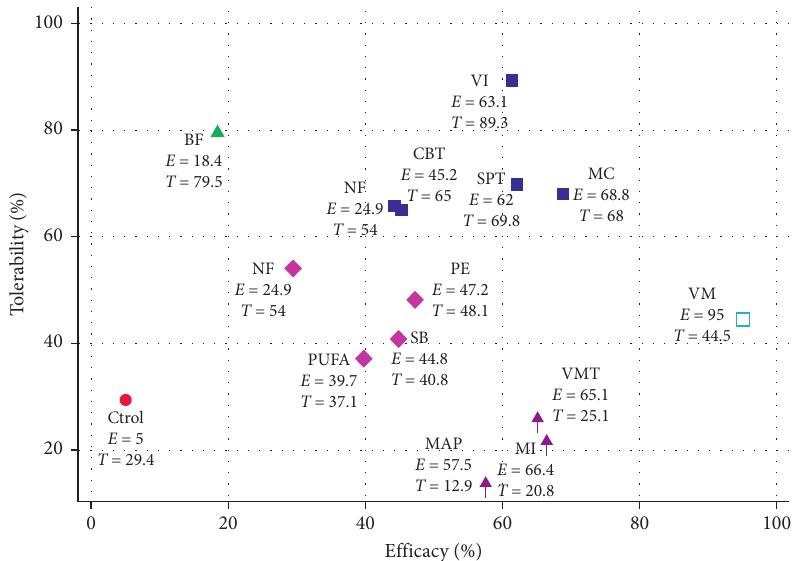
Figure 7: Treatment ranking and SUCRA plot for efficacy and